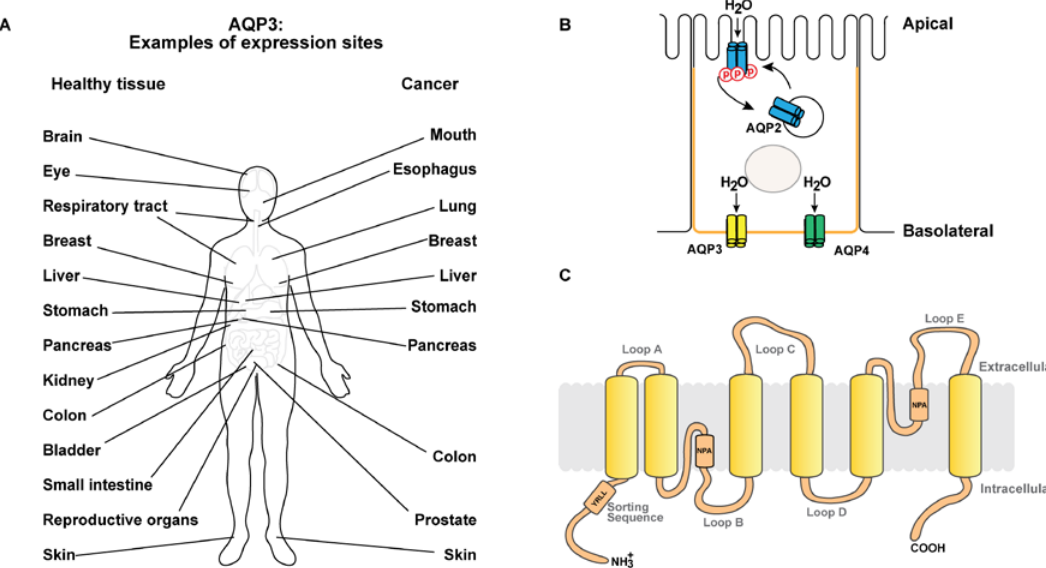
Figure 1. Aquaporin-3 expression sites, subcellular localization, and topology. ( A ) Schematic showing examples of aquaporin-3 (AQP3) expression sites as well as examples of cancers, where increased expression of AQP3 has been reported. ( B ) Schematic of a kidney collecting duct principal cell. Transepithelial water transport is facilitated by apical AQP2 allowing entry of water into the collecting duct principal cell and AQP3 and AQP4 in the basolateral plasma membrane domain (orange), which facilitate exit of water. AQP2 plasma membrane localization is regulated by phosphorylation (denoted by p in the schematic) mediating shuttling between intracellular vesicles and the apical plasma membrane. ( C ) Schematic showing the topology of AQP3. Similar to other AQPs, AQP3 has six transmembrane domains and intracellular COOH and NH 3+ termini. Two membrane-integrated helices with the conserved Asn-Pro-Ala (NPA) motifs generate the pore. AQP3 contains a basolateral sorting motif (YRLL) in the NH 3+ -terminal.